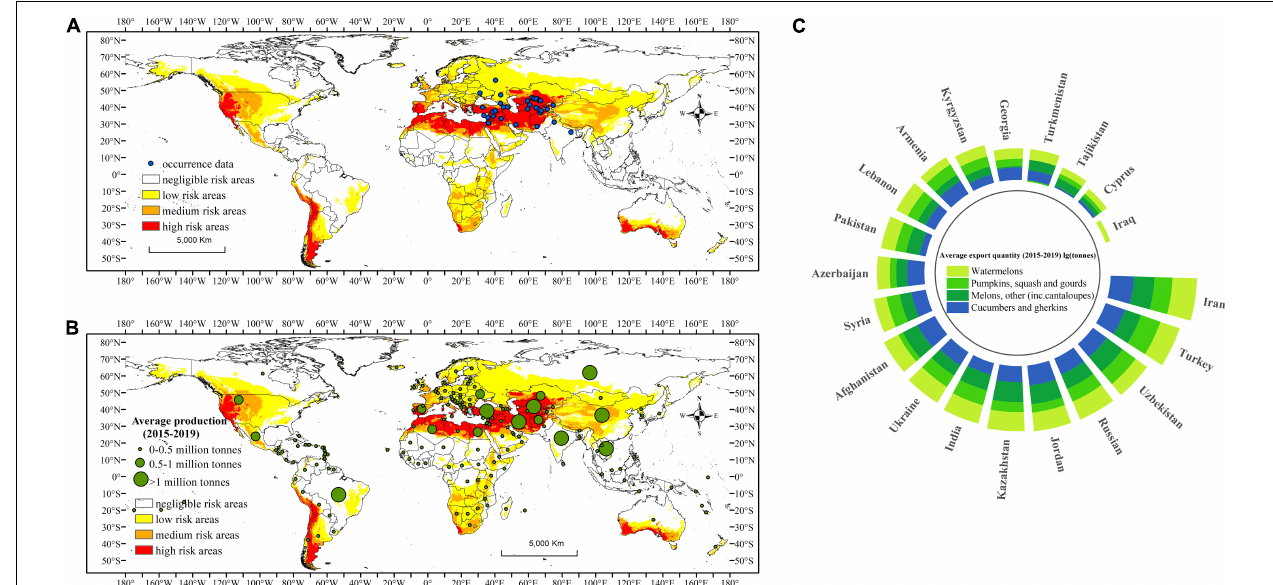
FIGURE 1 | Potential geographical distribution of Carpomya pardalina based on MaxEnt (v3.4.4) predictions using near-current climate data (averaged from 1970 to 2000). White indicates negligible risk areas (0.00–0.08), yellow indicates low risk areas (0.08–0.23), orange indicates medium risk areas (0.23–0.62), and red indicates high risk areas (0.62–1.00). (A) Blue points are occurrence data used to build and evaluate the model. (B) Green points are host production data averaged from 2015 to 2019. (C) Host export quantity of present countries averaged from 2015 to 2019 after